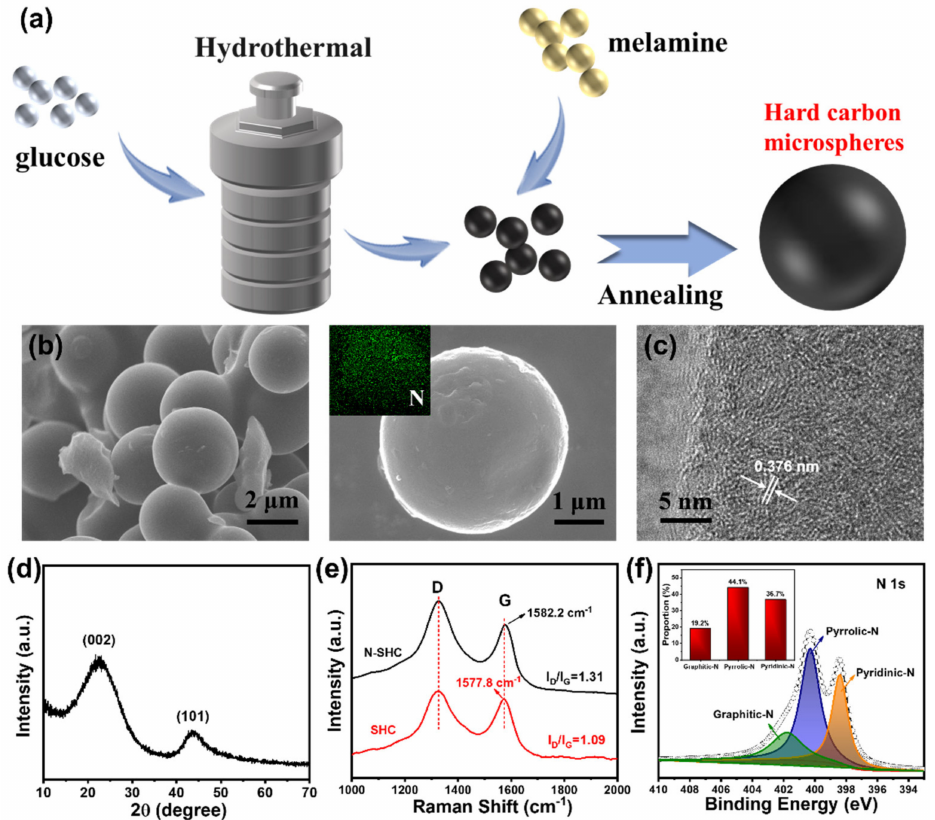
Figure 1. The ( a ) schematic of the synthesis process, ( b ) SEM images and EDS element mapping of as-prepared N-SHC, ( c ) TEM image, ( d ) XRD pattern, ( e ) Raman spectra and ( f ) high-resolution XPS spectra of nitrogen in